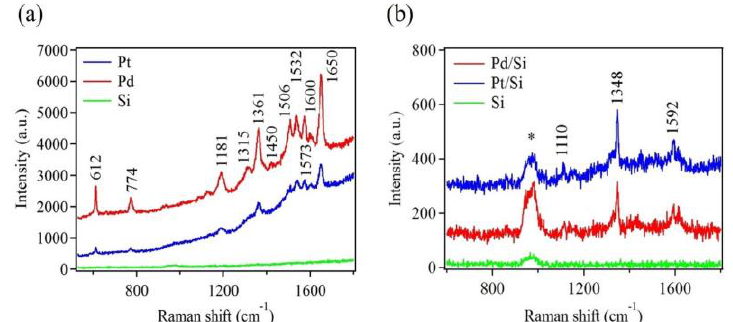
Figure 7. Raman spectra of ( a ) 10 −5 M Rhodamine 6G (R6G) and ( b ) 10 −2 M paraoxon adsorbed on Pd and Pt nanostructures deposited on Si substrates after ten deposition cycles. Raman spectra of R6G and paraoxon adsorbed on bare Si substrates are shown for comparison. The (*) indicates the Raman mode of Si.